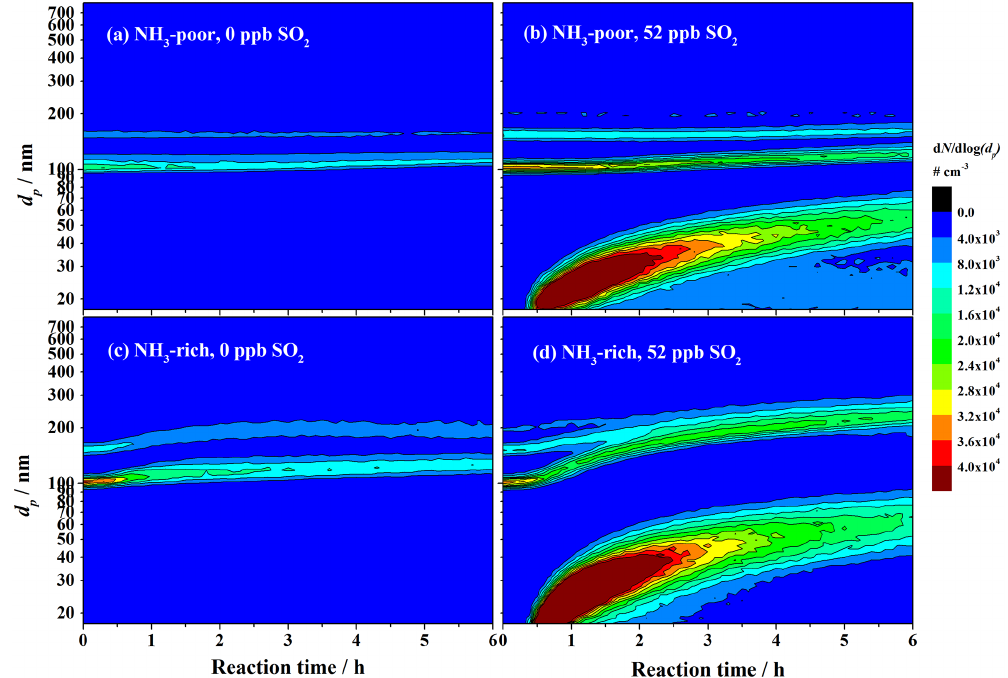
Figure 6. Size distributions of the suspended particles as a function of time during the reaction in photooxidation of toluene / NO x in the presence of Al 2 O 3 seed particles. Experimental details are listed in Table 1.